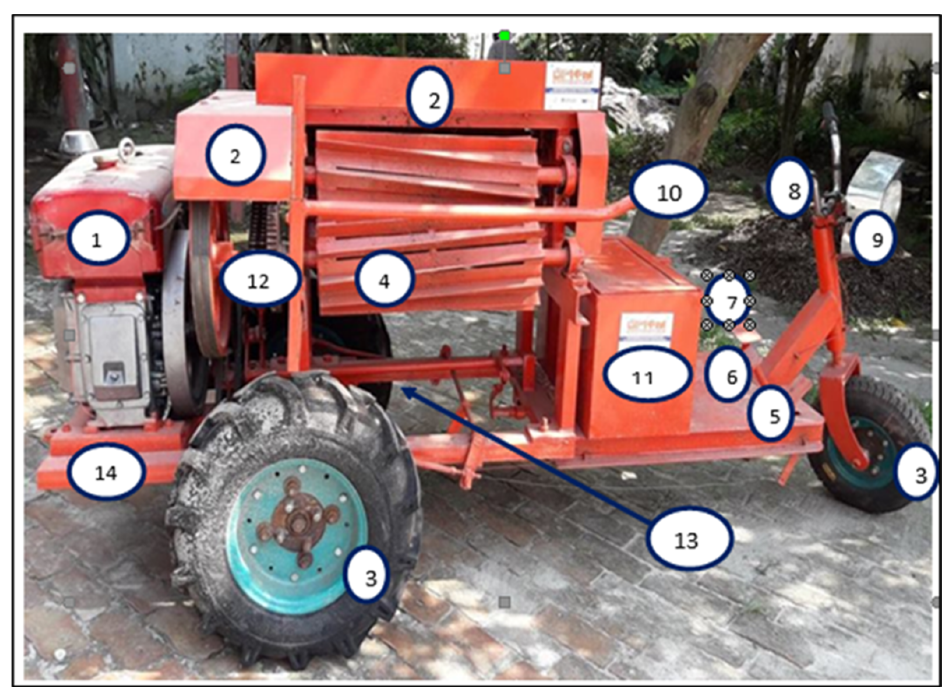
Figure 3. Different components of Aashkol are shown in the pictorial view from the side. 1. Engine; 2. Protection cover; 3. Wheels (two types); 4. Extraction roller; 5. Throttle lever/accelerator; 6. Brake; 7. Main clutch; 8. Handle; 9. Head light; 10. Fiber collection stand; 11. Seat cum toolbox; 12. Sprocket; 13. Differential gearbox; 14. Base frame.